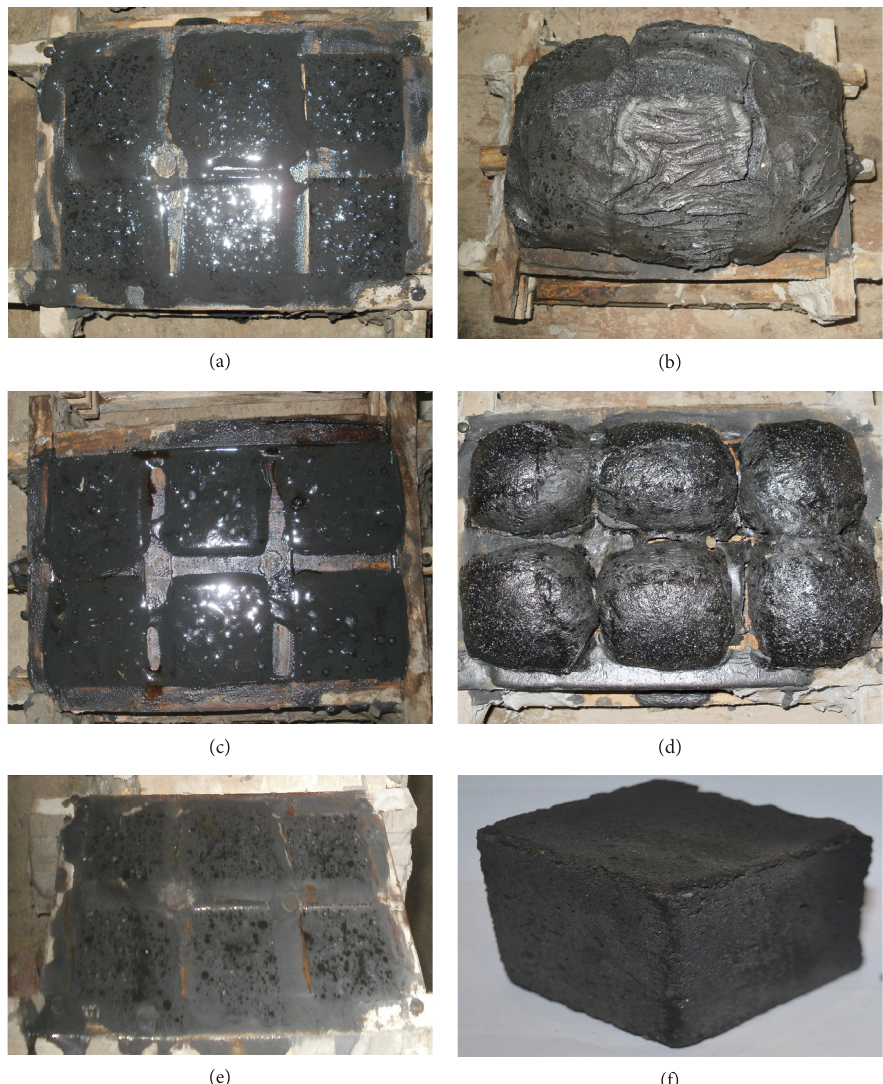
Figure 2: Physical appearance of the samples: (a, b) SMS1, (c, d) SMSB1, and (e, f)